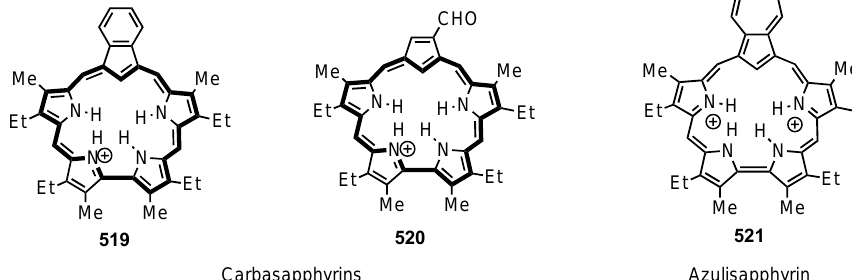
Figure 13. Carbasapphyrins.